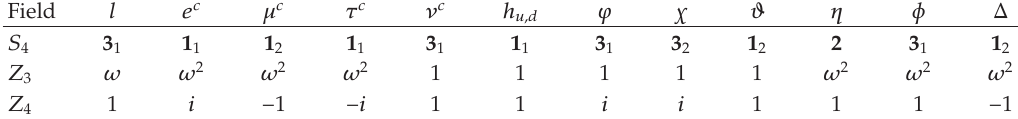
Table 2: Representations of the matter fields of lepton sector and flavons under S 4 × Z 3 × Z 4 .